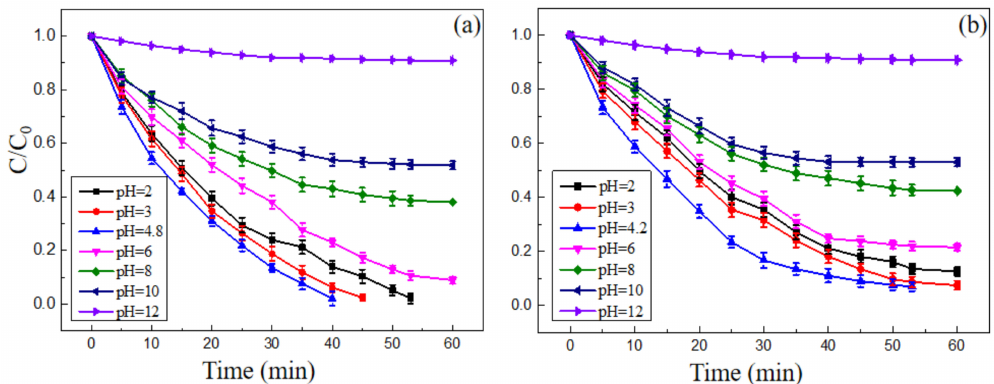
Figure 8. Effect of solution initial pH value on the degradation of ( a ) MB and ( b ) MO. Experimental conditions: initial H 2 O 2 concentration 18 mM for MB and 23 mM for MO, the composite catalyst synthesized with 8 × 10 − 4 mol/L CuCl 2 solution at 30 ◦ C.